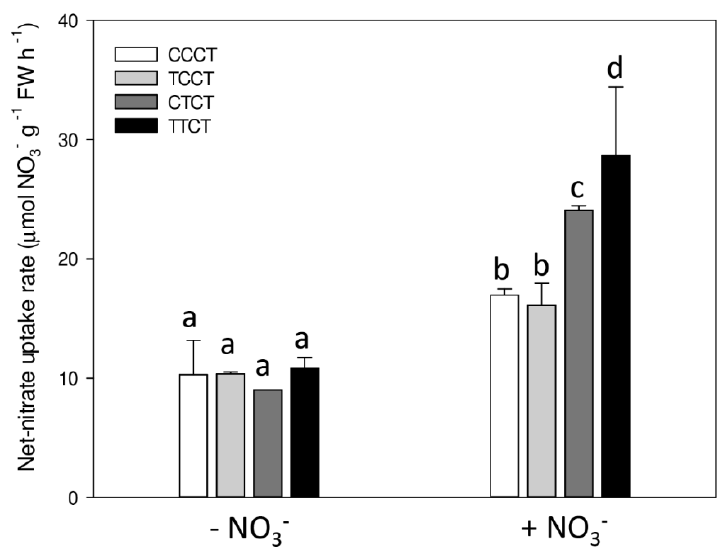
Figure 7. Net-uptake rate of nitrate into Arabidopsis roots of fourth generation plants. To evaluate the potential capability of Arabidopsis roots to take up nitrate, all plants were exposed to one week of N-limiting conditions before the assay. The day of the experiment, half the plants were maintained in N-free nutrient solution ( − NO 3 − ), while the other half were transferred to a nutrient solution containing 1 mM nitrate ( + NO 3 − ) and maintained in these solutions for 8 h. Six plants from each treatment were transferred to the assay solution (0.5 mM CaSO 4 containing 100 µ M nitrate) and incubated up to 10 min. The values are means + SD, small letters refer to statistical significance (Student-Newman-Keuls Method) method, N = 3, p -value < 0.05). FW, fresh weight.